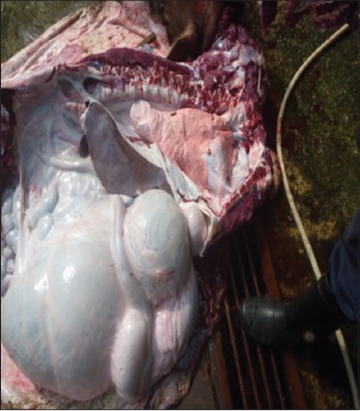
Normal organ in-situ.